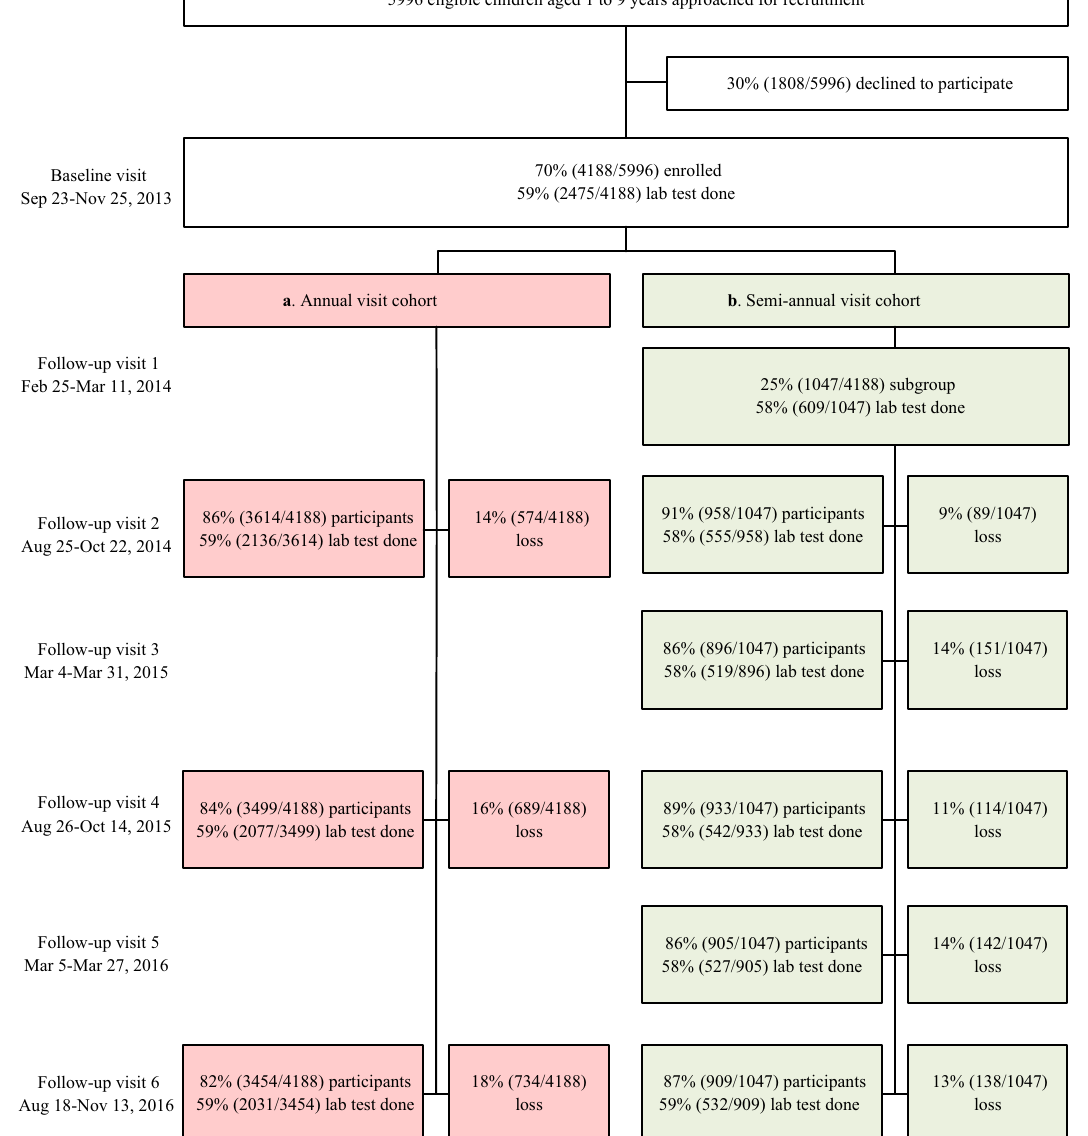
2014 – 2016. b The semi-annualvisit, i.e., an average of25%of enrolledparticipants in each age group were randomly selected to additionally participate in three follow-up visits between February and March during 2014 and